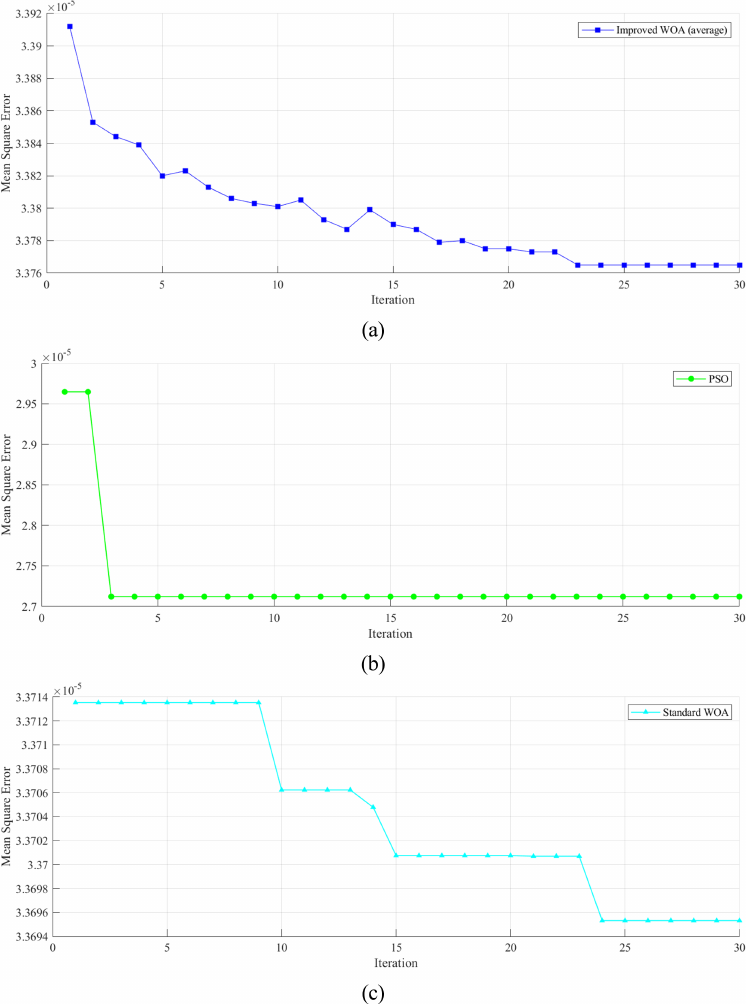
Figure 5. Best fitness obtained on the training set by each algorithm. ( a ) Best fitness obtained throughout iterations by improved WOA. ( b ) Best fitness obtained throughout iterations by